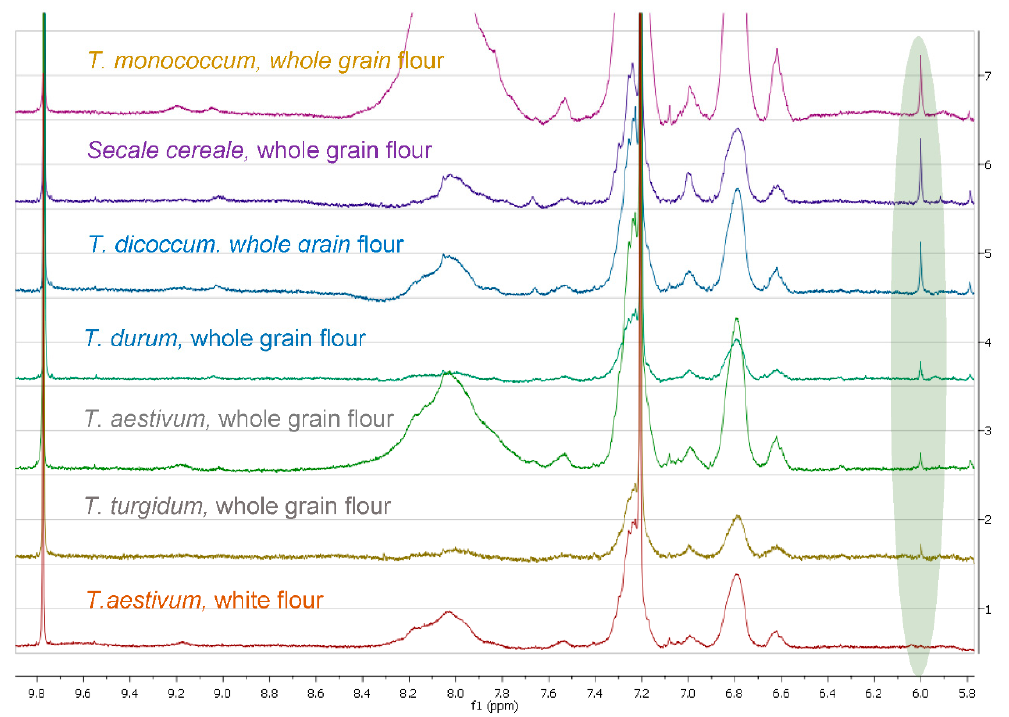
Figure 1. 1 H-NMR spectra in DMSO-d 6 of flour extracts. The highlighted peak corresponds to the total